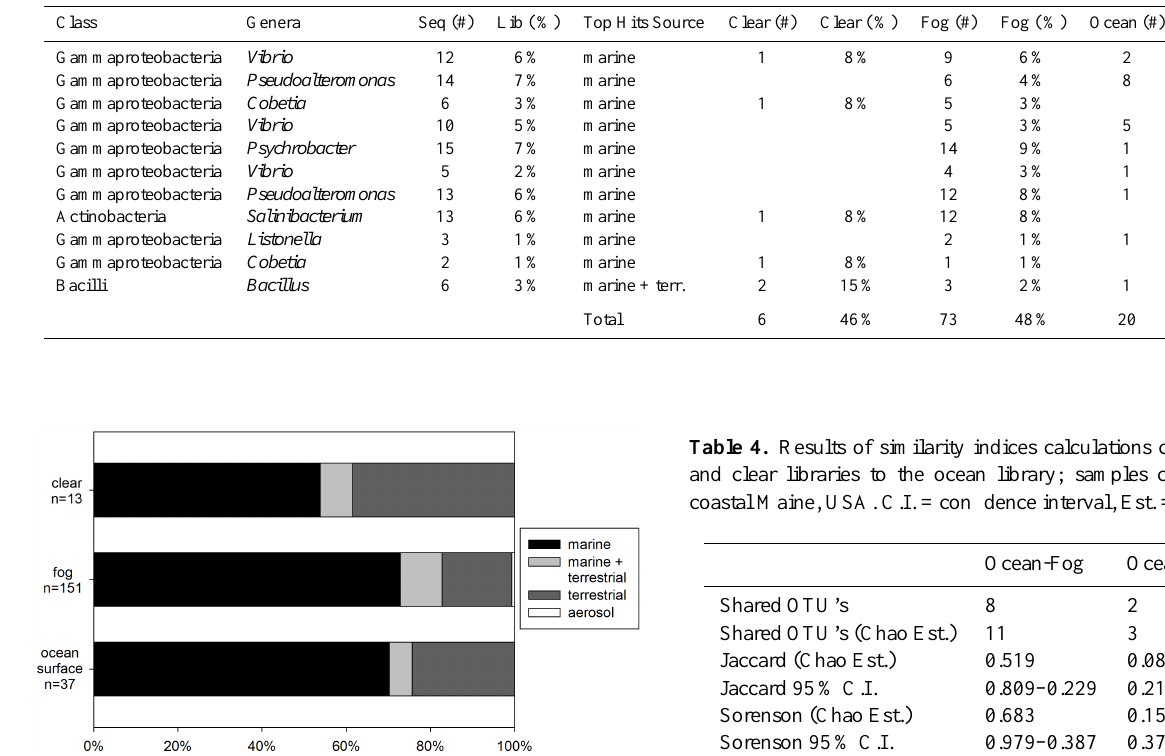
Table 3. Details for OTU’s shared between clear, fog, and ocean sequence libraries, coastal Maine, USA. OTU analysis from MOTHUR program using average neighbor and 97% similarity cut-off. Seq (#) is the number of sequences represented by the OTU, Lib (%) is the percent of overall sequence library represented by the OTU. Clear (#), Fog (#), Ocean (#) refers to the number of sequences from each library represented by the OTU. Clear (%), Fog (%), Ocean (%) refers to the percent of each sequence library represented by that OTU.